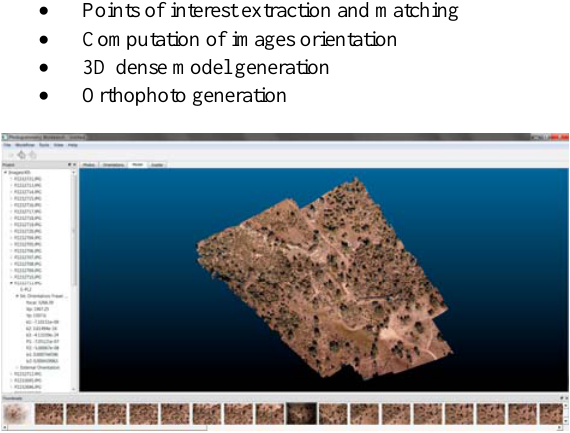
Figure 4. Layout of Photogrammetry Workbench